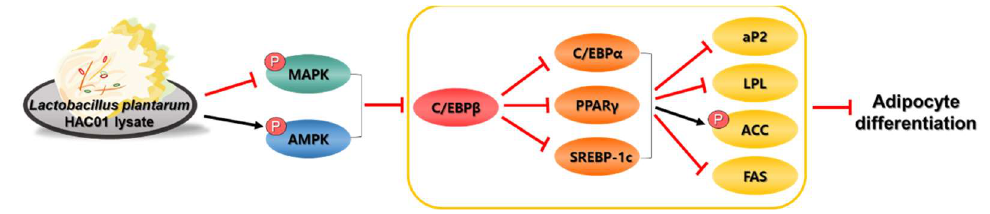
Figure 9. Schematic diagram of anti-adipogenic effects of Lactobacillus plantarum HAC01 lysate in 3T3-L1. L. plantarum HAC01 lysate suppresses on adipocyte differentiation the early stage of adipocyte differentiation via AMPK activation and MAPK inhibition. MAPK, mitogen-activated protein kinase; AMPK, adenosine monophosphate-activated protein kinase; C/EBP, CCAAT/enhancer-binding protein; PPARγ, peroxisome proliferator-activated receptor gamma; SREBP-1c, sterol regulatory element-binding protein 1c; aP2, adipocyte protein 2; LPL, lipoprotein lipase; ACC, acetyl-CoA carboxylase; FAS, fatty acid synthase.